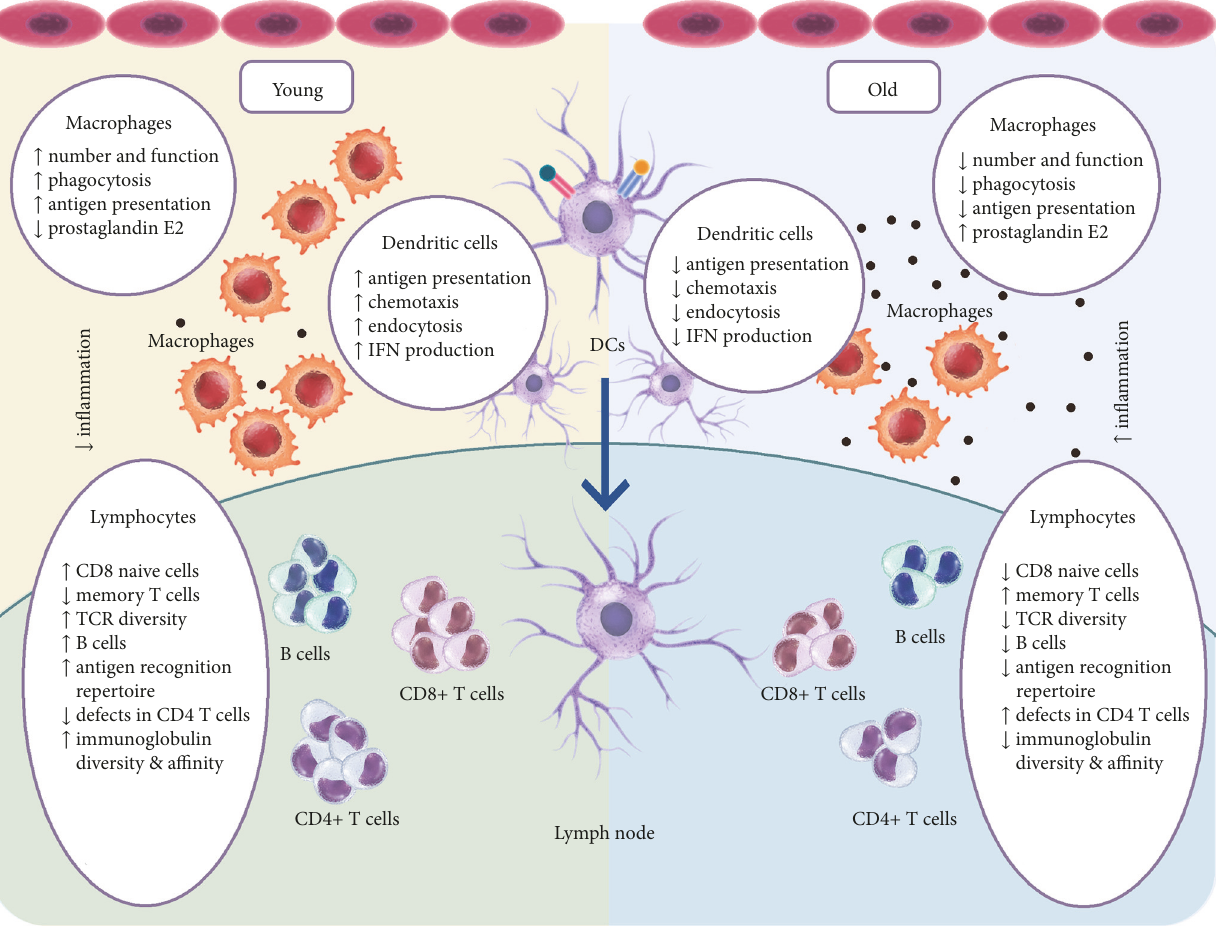
Figure 6: In fl ammaging drives immunosenescence. Chronic low-grade in fl ammation results from reduced function of the aging innate and adaptive immune systems. In old age, the number of macrophages, as well as phagocytosis, decreases. Likewise, dendritic cells lag in antigen uptake, as well as in migration to lymph nodes. While B and T cell e ff ector responses become less than optimum, a notable expansion of memory CD8+ T cells is